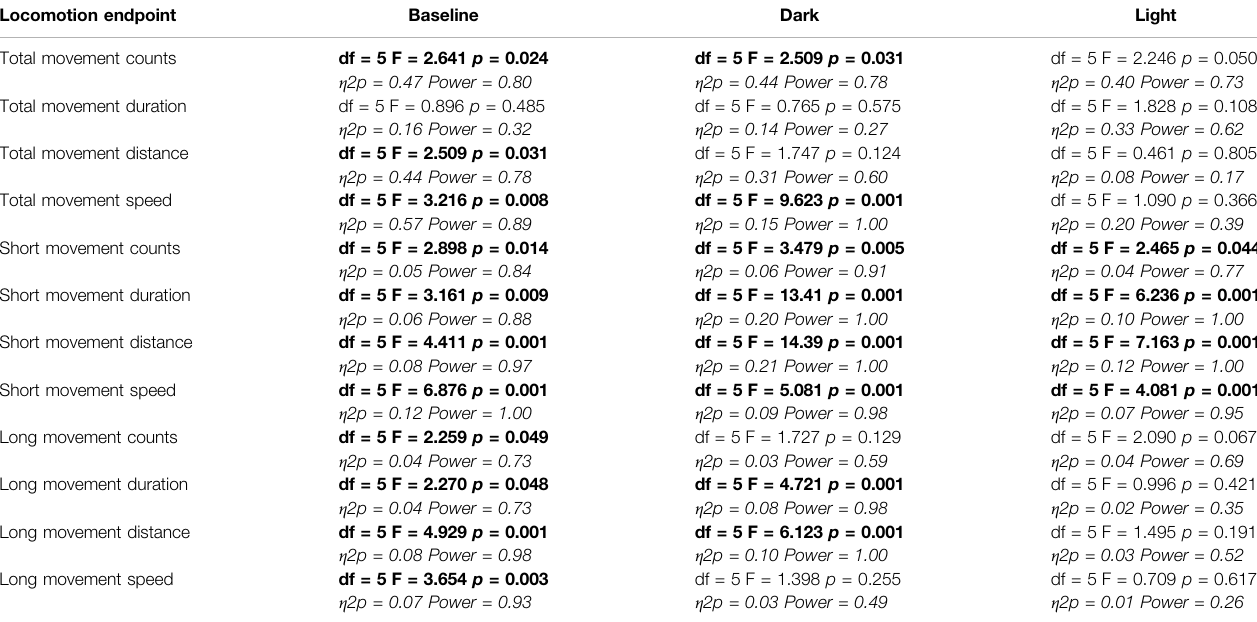
TABLE 2| RepeatedmeasurementANOVA analysesoftreatment effectsonlocomotion assayendpoints.Effectsizesandobservedpower arereported.Boldfontindicates signi fi cance at a p < 0.05 threshold. Locomotion